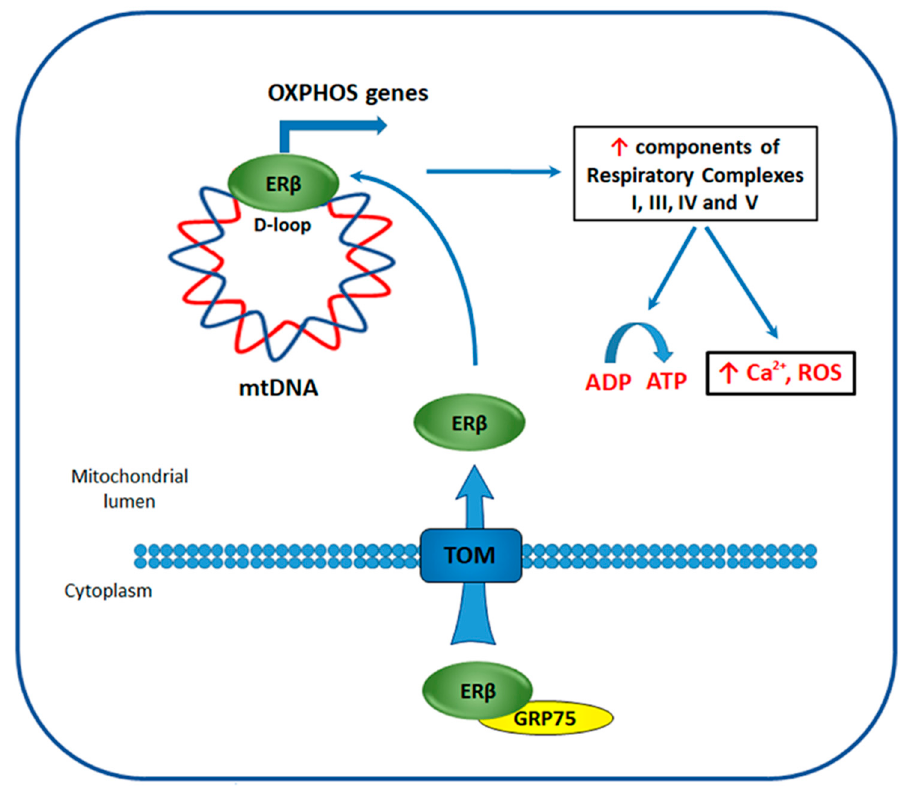
Figure 5. Proposed mechanism of ER β‐ mediated regulation of oxidative phosphorylation (OXPHOS) in TNBC. ER β interacts with glucose ‐ regulated protein 75 (GRP75) and undergoes translocation into the mitochondria with the aid of the translocase of the outer membrane (TOM) complex. In mitochondria, ER β binds to mitochondrial DNA (mtDNA) in displacement loop (D ‐ loop) region and drives the expression of genes encoding for the components of respiratory complexes I, III, IV, and V, responsible for OXPHOS. OXPHOS activation leads to an increase of mitochondrial Ca 2+ , reactive oxygen species (ROS), and ATP concentrations.